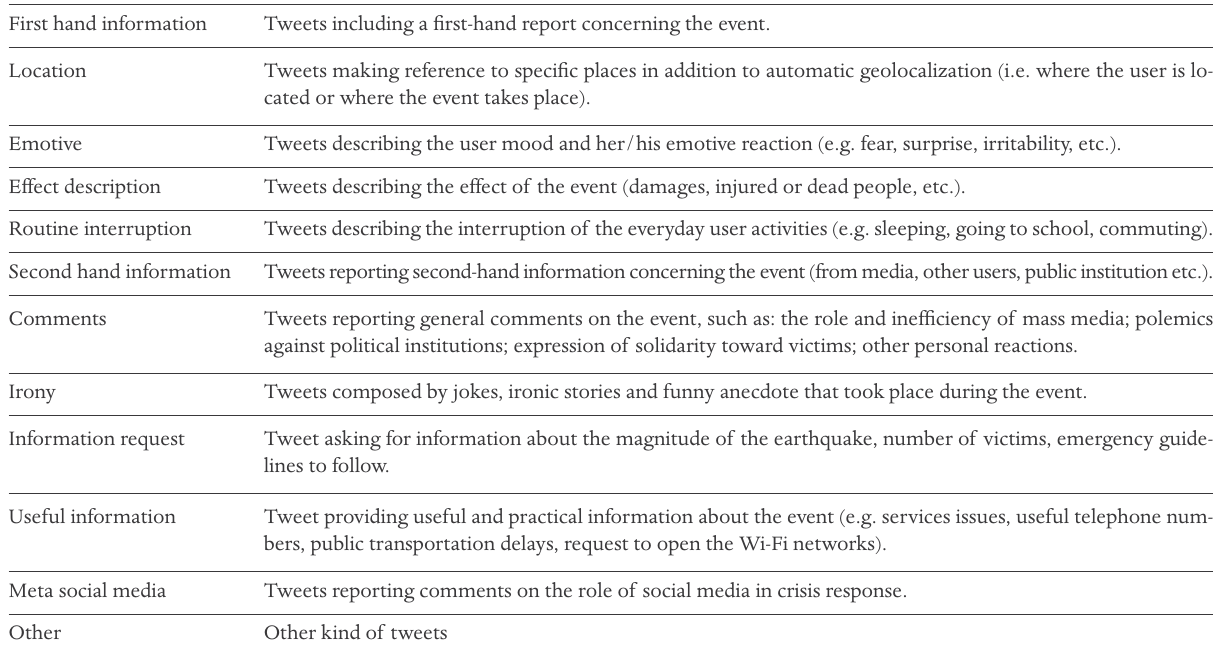
Table 6. Categories of the tweets written in the two hours after the first two major shakes (occurred on May 20, 2012, 2:03:52 a.m.-3:59 a.m. UTC, and on May 29, 2012,